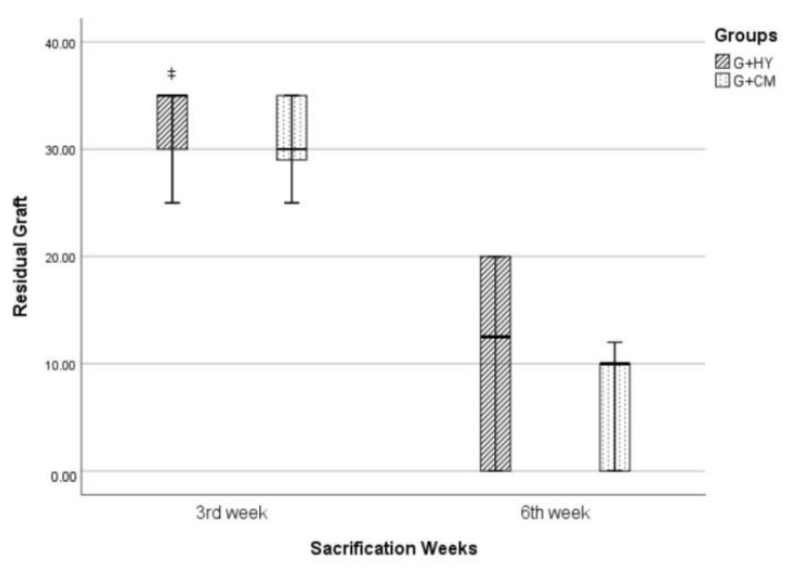
Figure 8. ǂ p < 0.001 when compared with